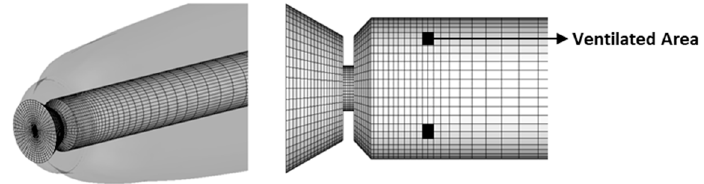
Figure 9. Schematric view of the computational model and cavitation shape for σ c = 0.19.